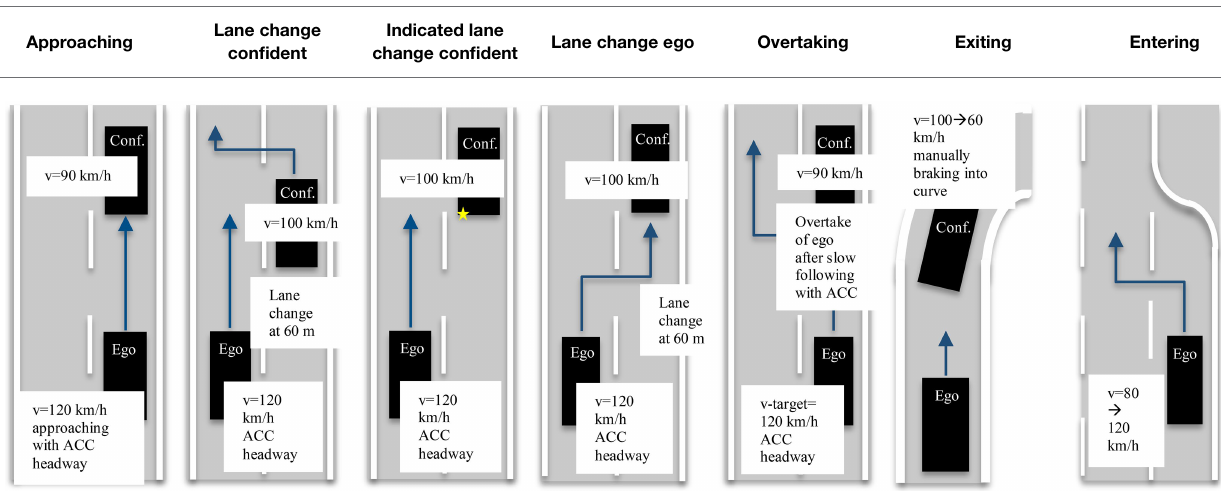
TABLE 1 | Description of situations performed during each